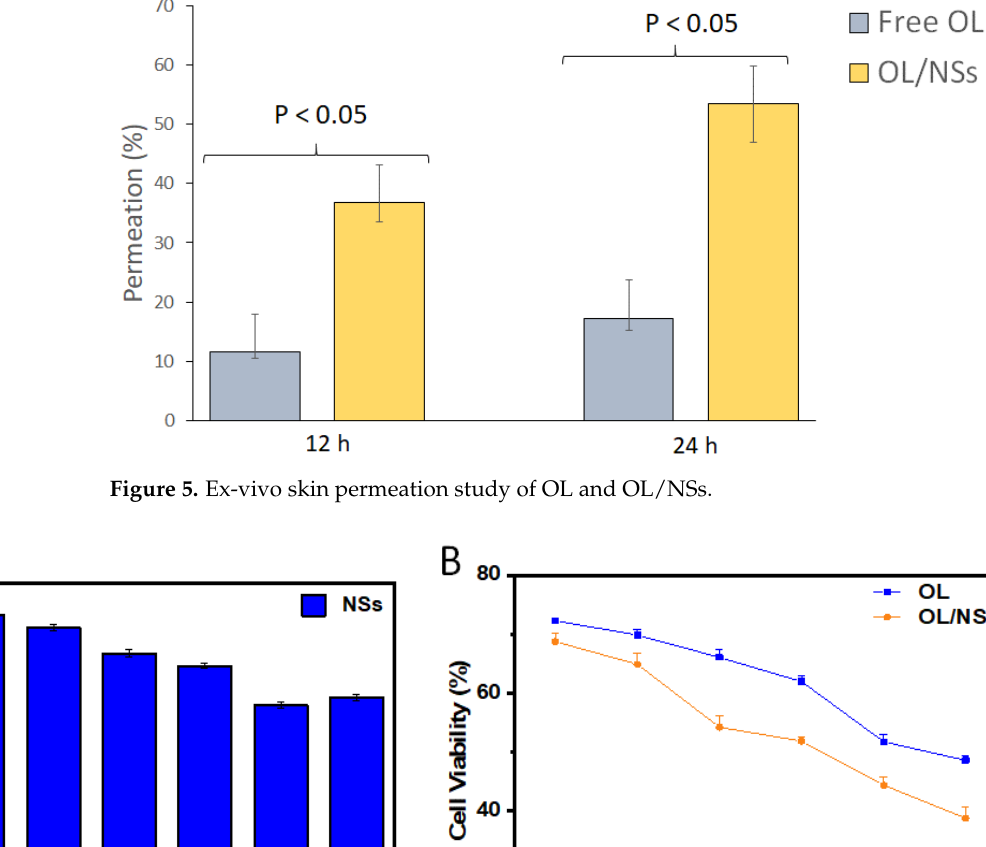
Figure 5. Ex-vivo skin permeation study of OL and OL/NSs.